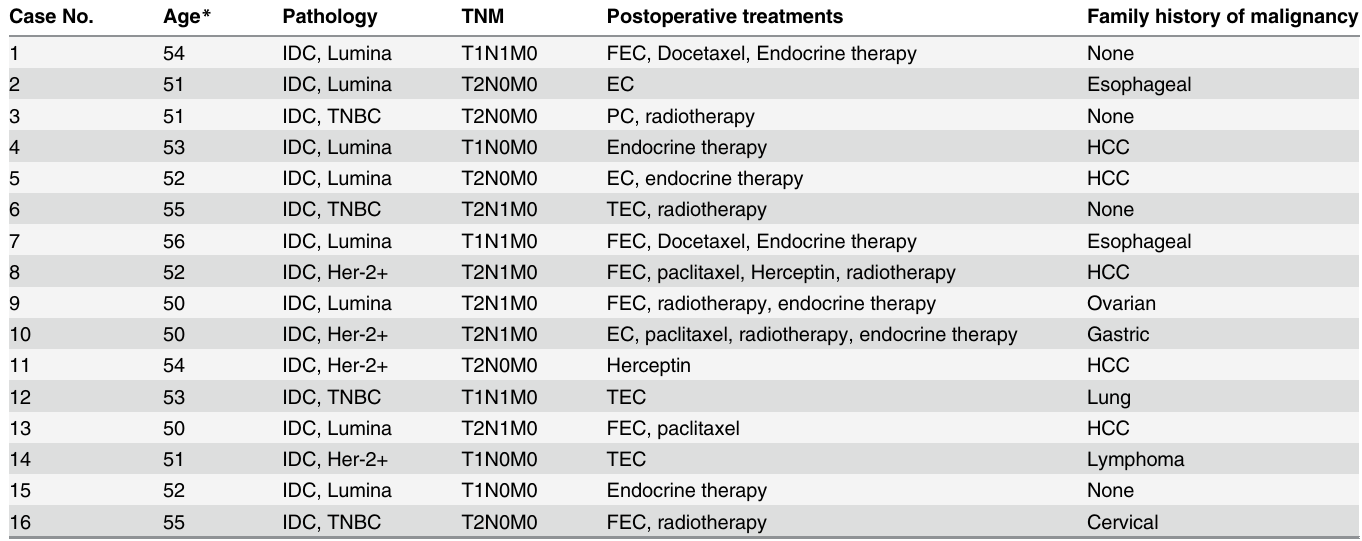
Table 1. The characteristics of the first primary breast cancer and postoperative treatments. Case No.